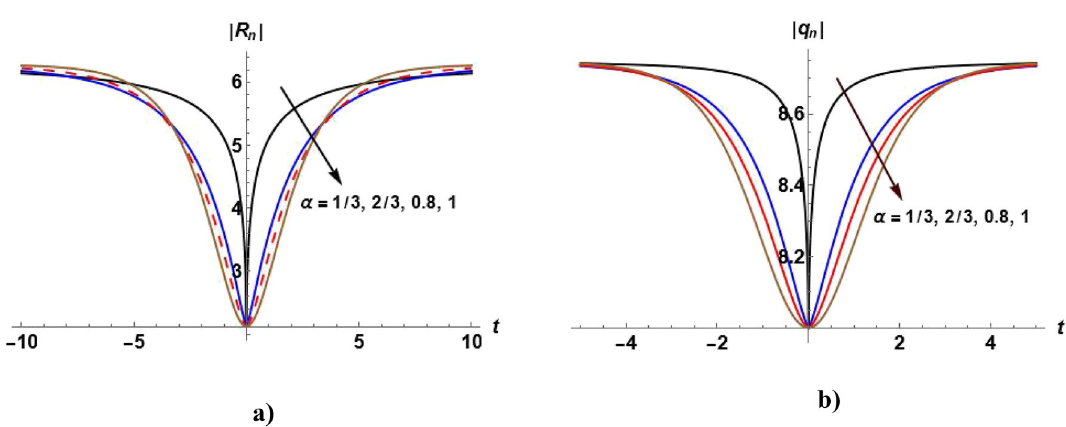
Figure 2. Plot of the solutions (32) and (33) when c 1 values of n for different values of α